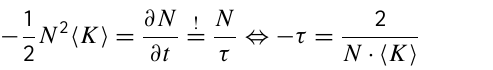
Fig. 2. Fits on calculated aggregation kernels for different geometric standard deviations. Upper panel: aggregation kernels vs. modal mass. The change due to the width of the distribution can be seen clearly. Lower panel: aggregation kernels vs. mean mass. Since the mean mass depends on the geometric width of the distribution, the variation of the kernels due to different width is smaller. Additionally, the aggregation kernel as derived by Schumann (2012) is shown for comparison. The corresponding sizes range between a modal length of 0.6 and 8000 µ m.